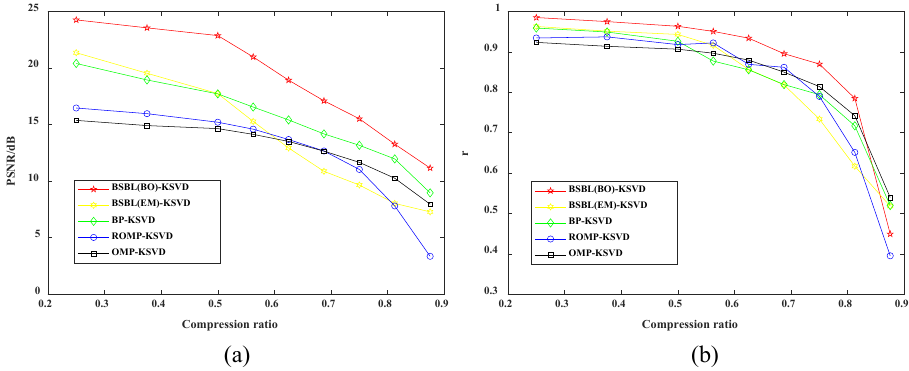
Figure 6. Comparative analysis of different compression and reconstruction methods: ( a ) peak signal-to-noise ratio evaluation and ( b ) Pearson correlation coefficient.